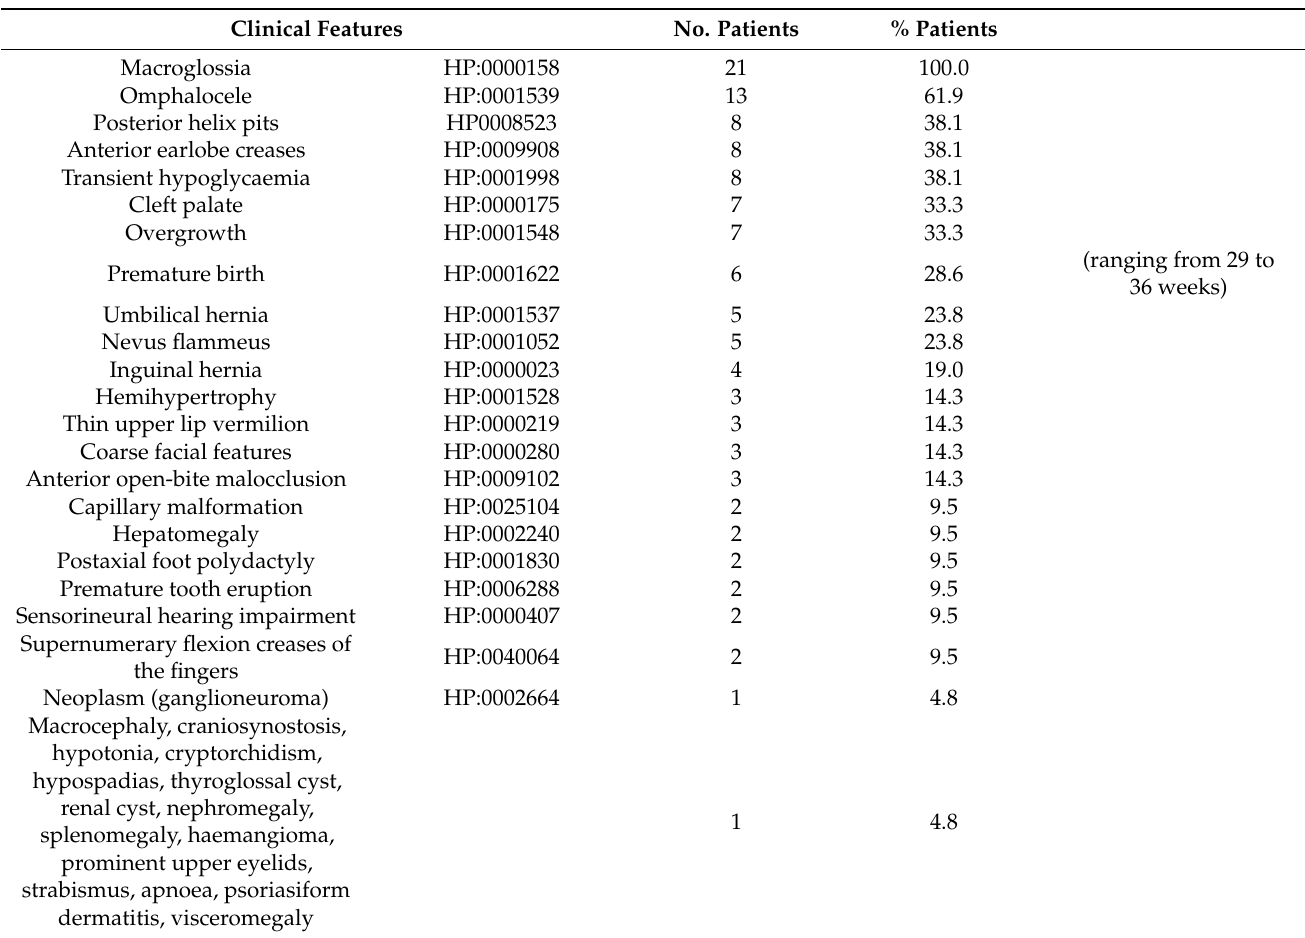
Table 2. Clinical Features Observed in 21 Patients with